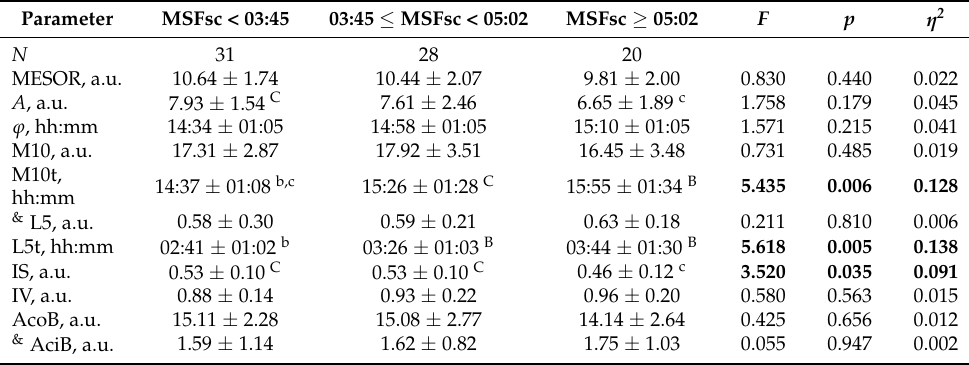
Table 2. Association of chronotype with 24 h rest–activity rhythm characteristics.